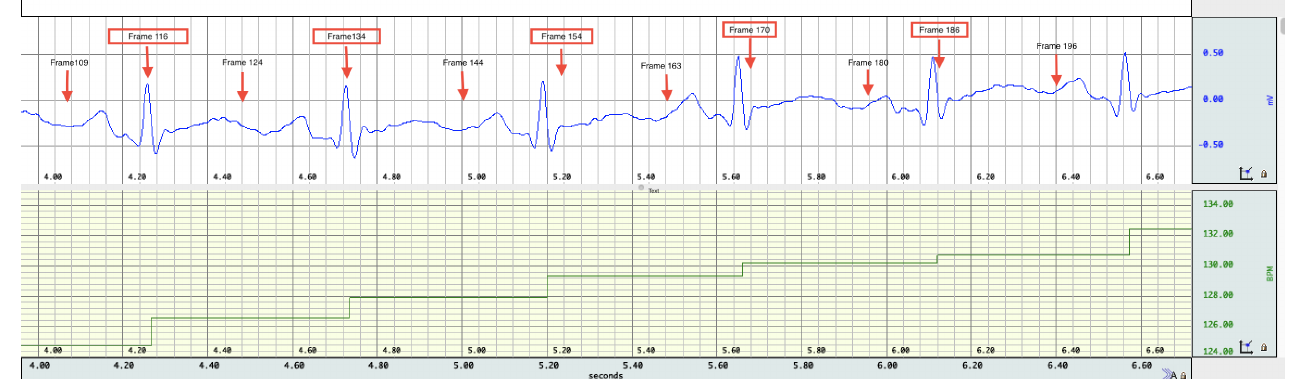
Figure 13. EKG data collected with BIOPAC during breath-holding. Frames from Figures 11 and 12 are annotated on the EKG trace in the upper half of the image. One sees that systole in the EIT images closely coincides with the QRS complex in the EKG data, as would be expected. The average heart rate is found in the lower half of the figure.